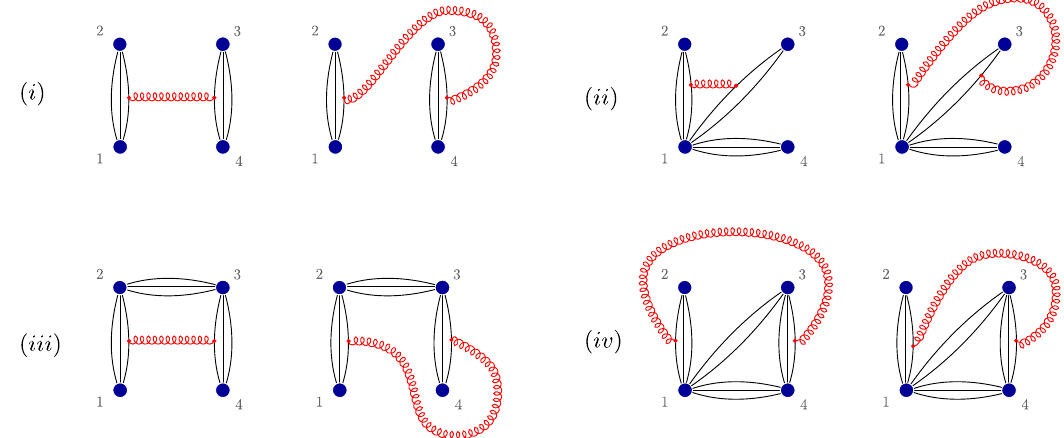
Figure 10 . Structure of the one-loop diagrams for the four \edge-reducible" graphs. We planarly attach a YM line to the matter propagators in all possible ways. As described in the text, the colour factor of ( i ) is zero for each diagram. For ( ii ), there is no contribution to the four-point integral, since only three-point topologies arise. For case ( iii ) the colour factors only cancel between the two diagrams depicted, and similarly for case ( iv